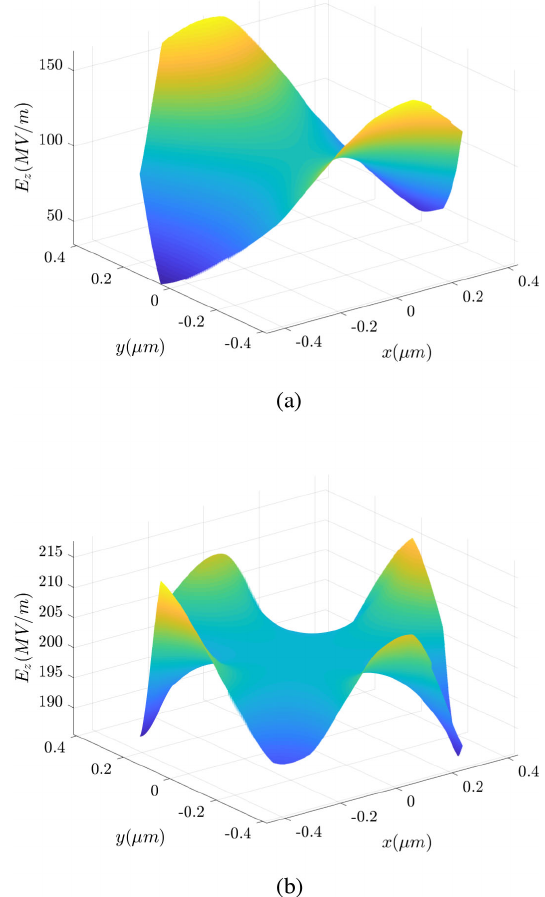
electrons.FIG. 4. (a) The rms beam energy as a function of transverse coordinates in a rectangular waveguide correlated with the transverse dependency of quadrupole component of E are for a slice electron beam with 100 μ m radius resulting in a 7 MV = m rms field deviation. (b) The energy distribution for the same beam after propagating through the orthogonal multistage arrangement. In the latter, the correlated rms spread in the field is reduced down to 0 . 5 MV =